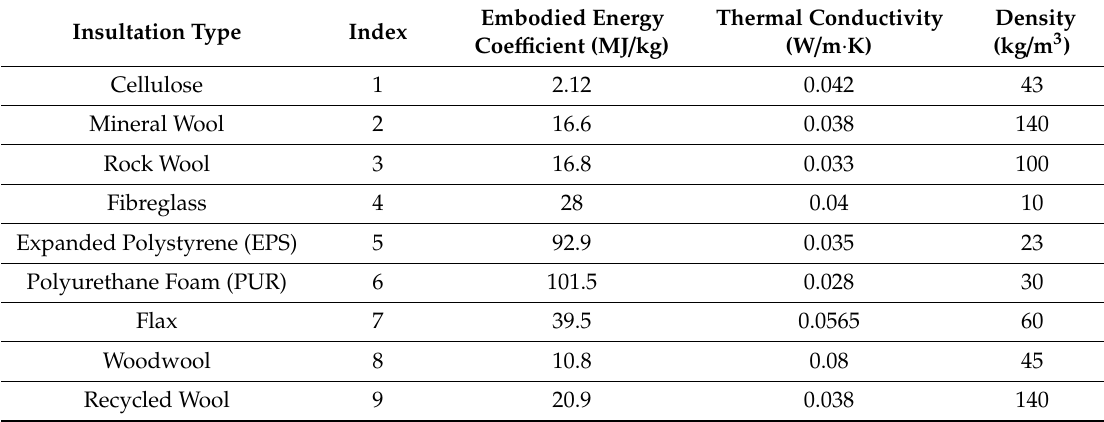
Table 3. Insulation Types and